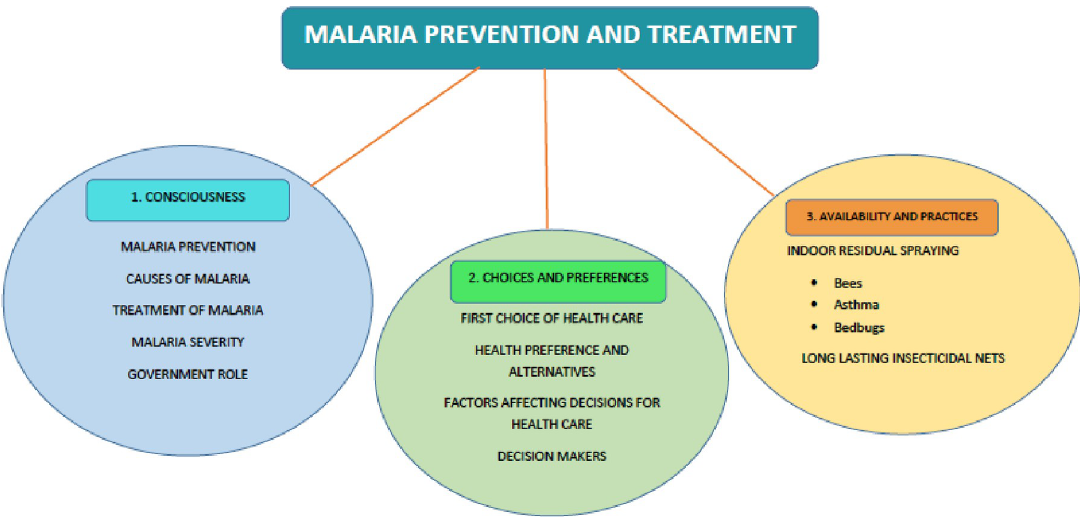
Fig 1. Concept map of identified